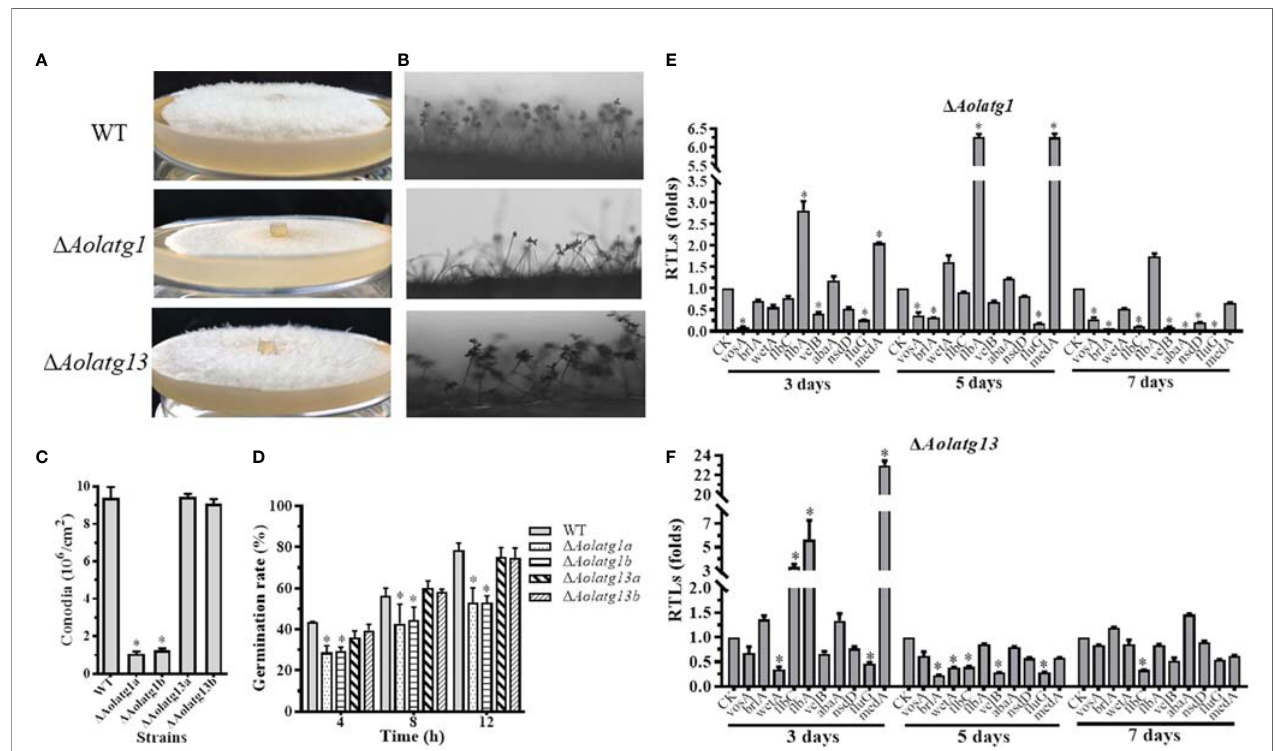
FIGURE 2 | Comparison of conidiation and transcript levels of sporulation-related genes in the WT and mutant strains of A. oligospora . (A) Observation of aerial hyphae in the WT and mutant strains. (B) Observation of conidiophores in the WT and mutant strains. (C) Comparison of conidia yields in the WT and mutant strains. (D) Comparison of the germination rate in the WT and mutant strains. (E) The relative transcription levels (RTLs) of the sporulation-related genes in the WT and D AolATG1 mutant strain. (F) The RTLs of sporulation-related genes in the WT and D AolATG13 mutant strain. RTLs of the sporulation-related genes were assessed by comparing the levels of their transcription in the mutant strain with that of the WT strain. CK is the standard used in statistical analysis of the RTL of each gene in the deletion mutant compared to that in the WT strain under any given condition. Data are presented as the mean ± standard deviation. Statistical signi fi cance of differences between mutant strains and WT strain is indicated as follows: * P < 0.05 (Tukey ’ s